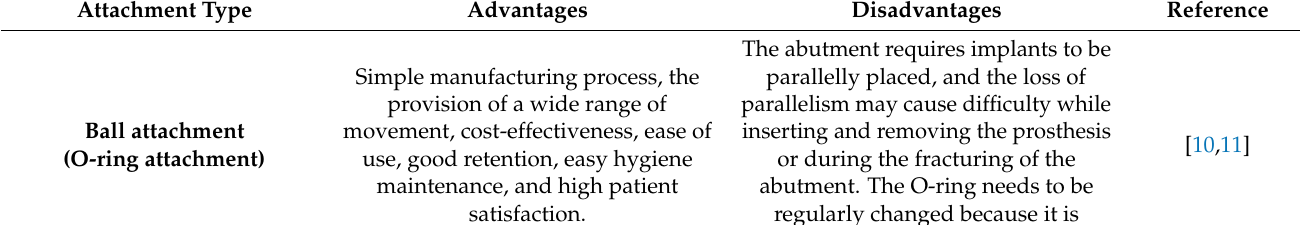
Table 2. Advantages and disadvantages of the various attachments in